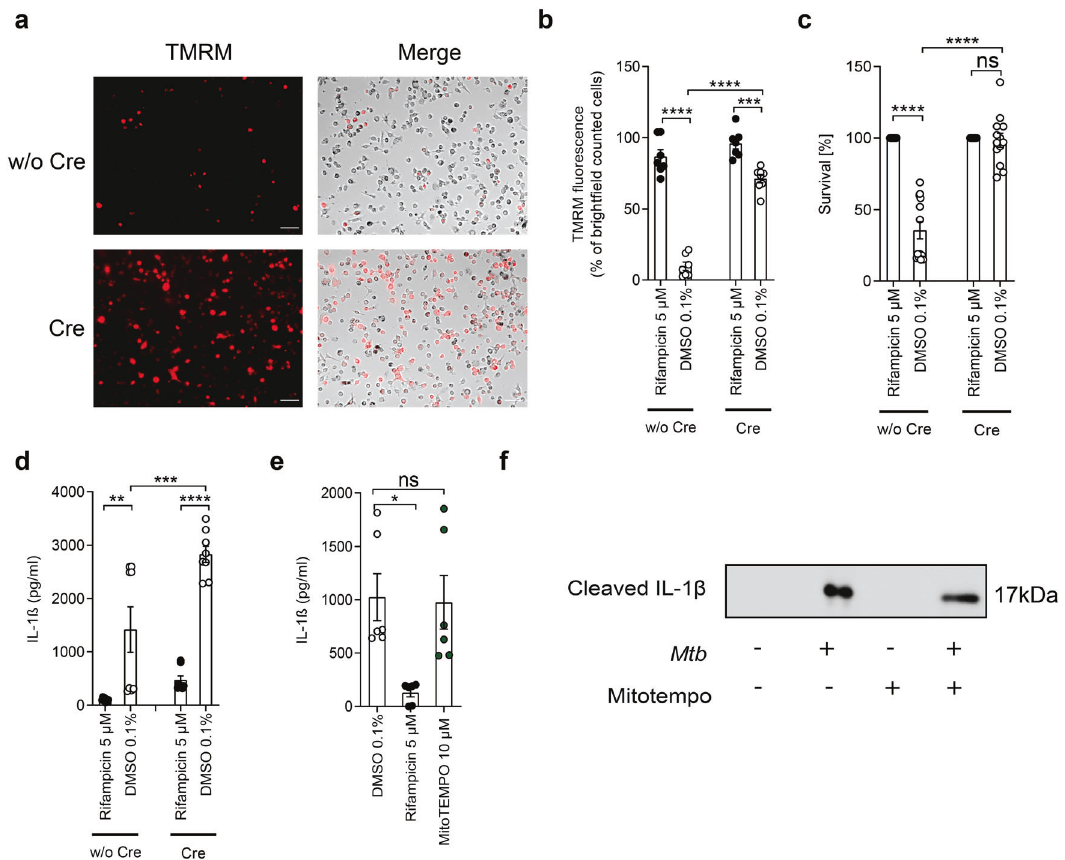
Fig. 2 Manipulation of regulators of the mPTP reduces mitochondrial damage. a Representative images and b quanti fi cation of Mtb - infected Bcl-2-overexpressing BMDMs treated with or without (w/o) Cre and stained with TMRM 24 h post infection (scale bar: 100 μ m; n = 7). c Survival of bone-marrow derived macrophages (BMDMs) from Bcl-2-overexpressing mice treated with or w/o Cre to induce Bcl-2 overexpression ex vivo. Viability of Mtb -infected BMDM (MOI 3) was quanti fi ed 24 h post infection using DAPI staining. Rifampicin-treated BMDMs were used as controls and their survival was set to 100% ( n = 13). Data from two experiments with multiple replicates are shown. d Quanti fi cation of IL-1 β concentration in the supernatant of Bcl-2-overexpressing BMDMs ( n = 6). e Quanti fi cation of IL-1 β concentration in